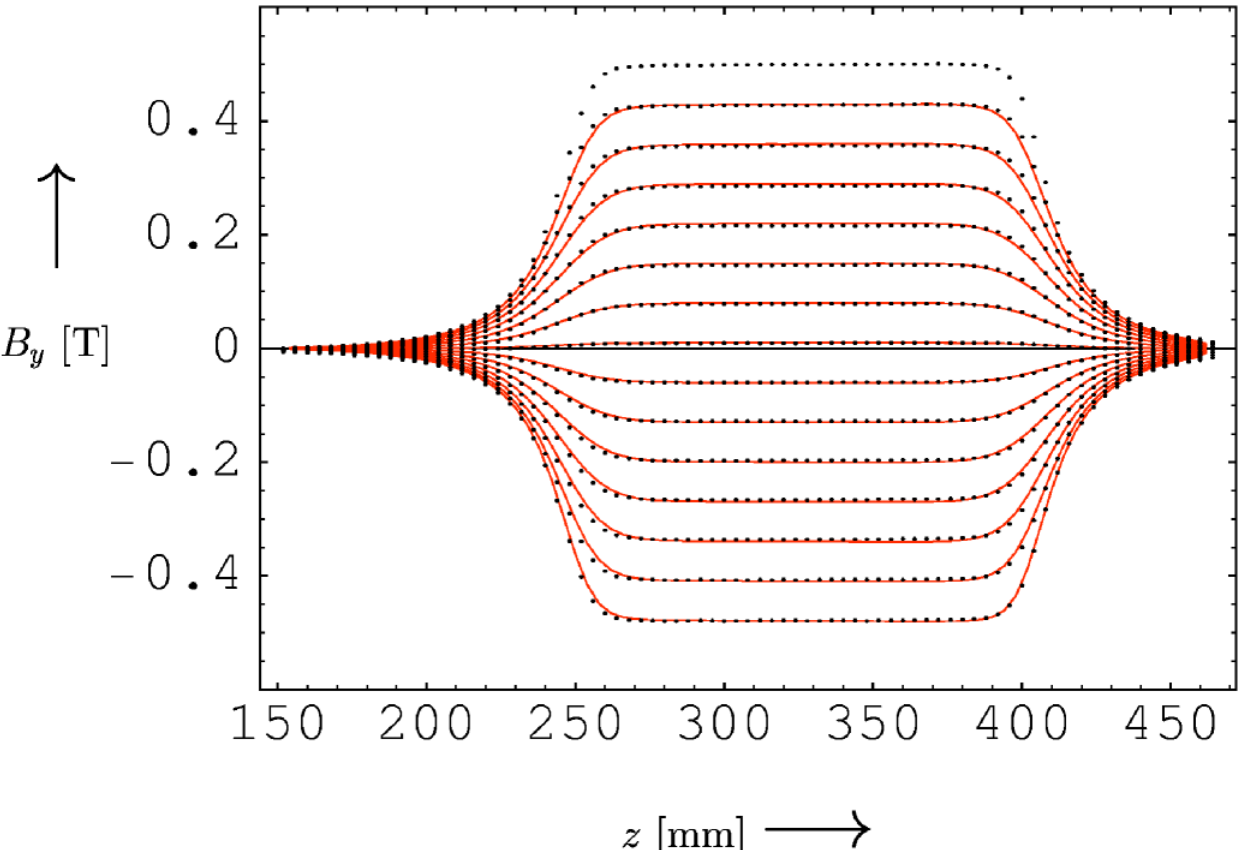
FIG. 1. (Color) Comparison of the measured and calculated B y as a function of z for various values of x . The black dots represent the measurements, the red curves indicate the calculated field. The top row of measurements served as input for the calculations.